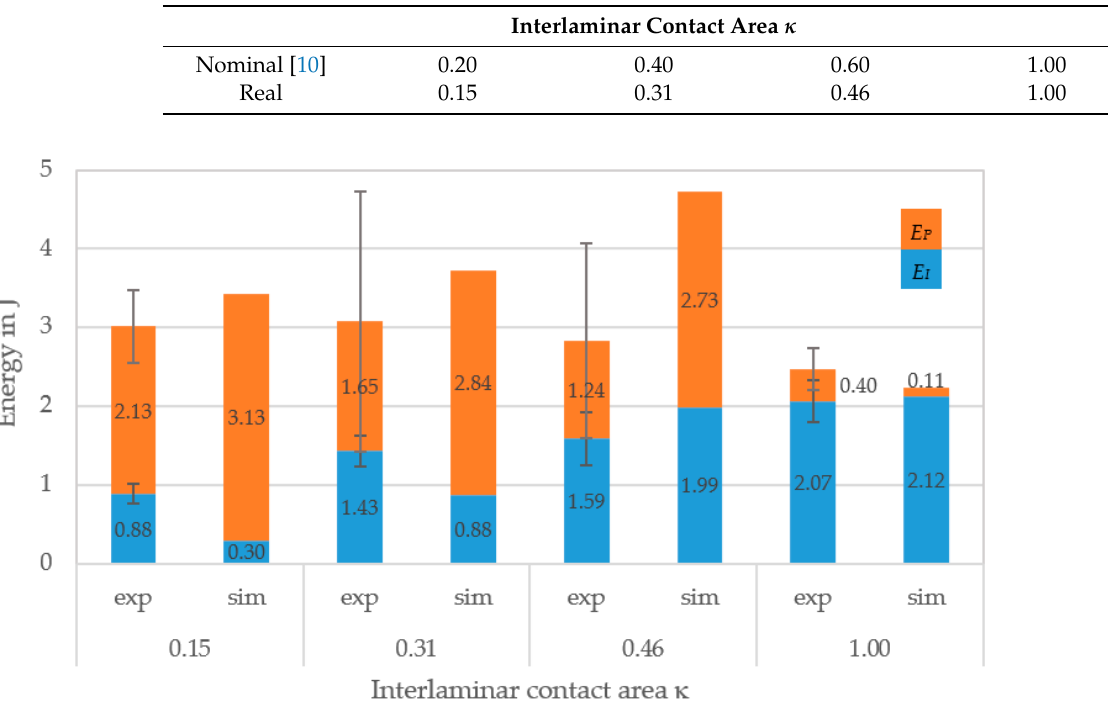
Table 3. Nominal values [10] and values resulting from the manufacturing process for interlaminar contact area.